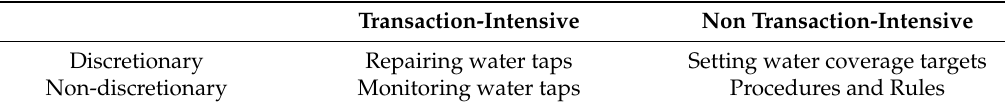
Table 6. Tasks and their amenability to improvement through digitization (SEMA